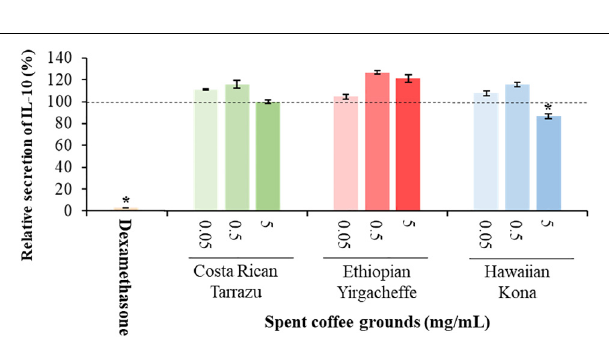
FIGURE 3 | Effect of spent coffee ground extracts on the secretion of IL-6 by PMA-differentiated, LPS-stimulated U937 cells. Dexamethasone was used at 0.2 µ g/mL as a positive control. (*) Significant decrease ( p < 0.001) compared to PMA-differentiated, LPS-stimulated U937 cells in the absence of extract. Mean ± SEM.